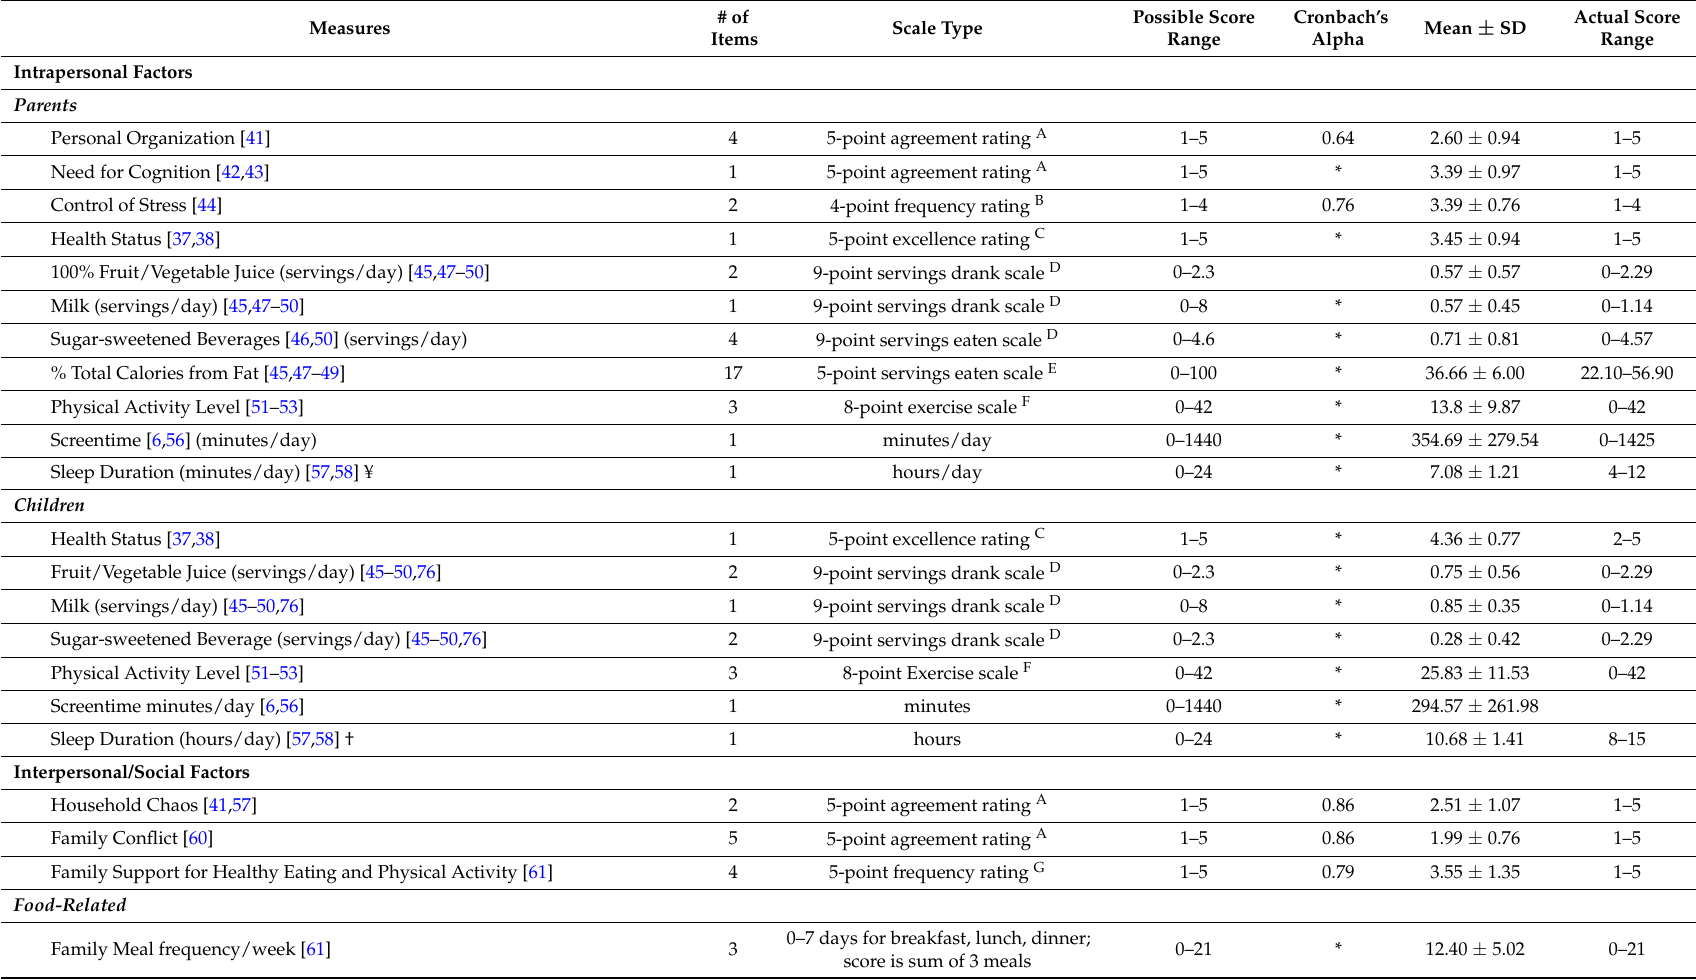
Table 1. HomeStyles Study Measures and Baseline Scores ( n =